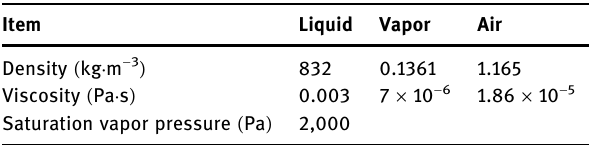
Table 3: Properties of diesel